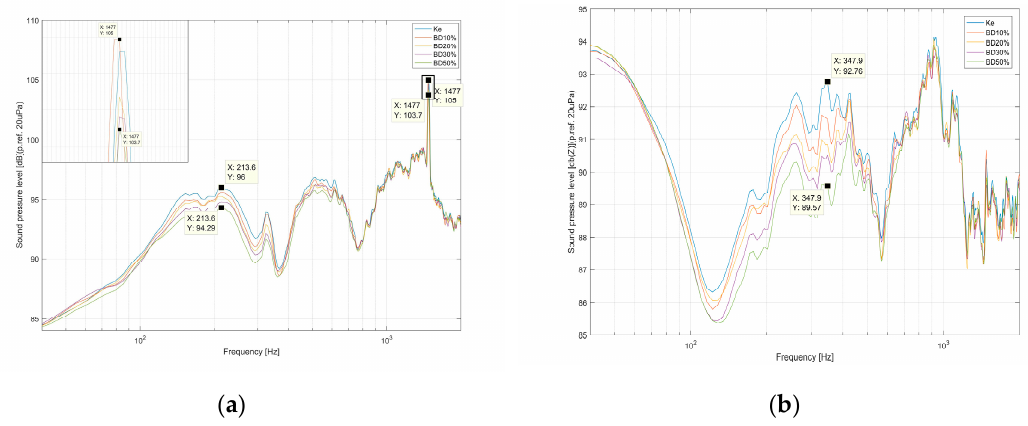
Figure 14. Noise–FFT (Fast Fourier Transformation) time domain analysis for all blends, regime 3 (( a ) Mic 1, ( b ) Mic 2).